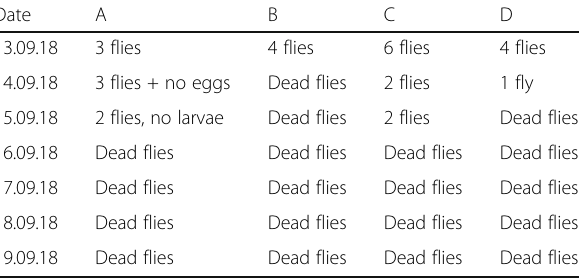
Table 4 Culture of flies in 1.5 ppm NaF in four different bottles